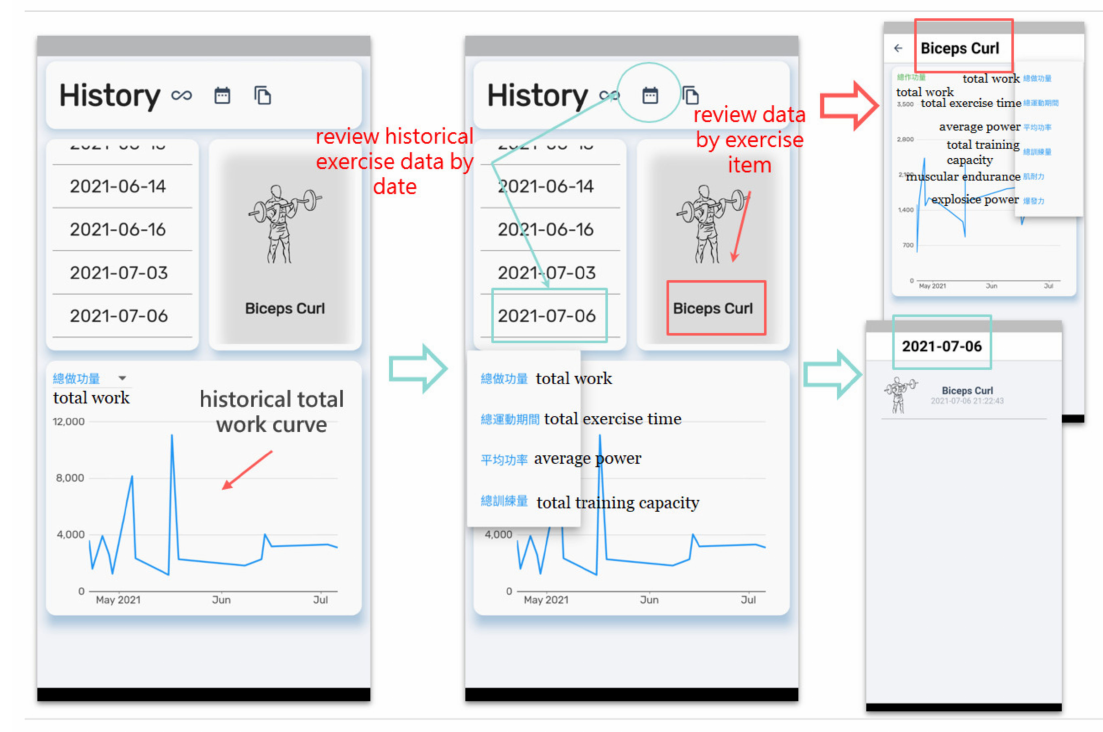
Figure 14. GUI of historical data.